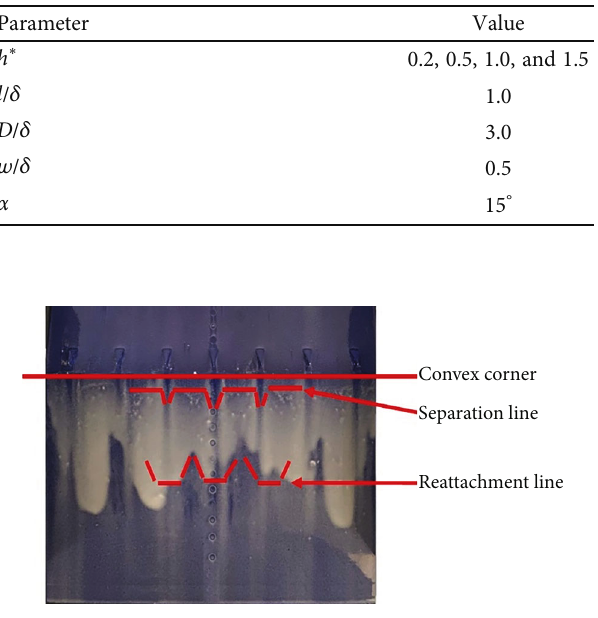
Figure 3: An example of oil fl ow visualization for h ∗ = 0 : 5